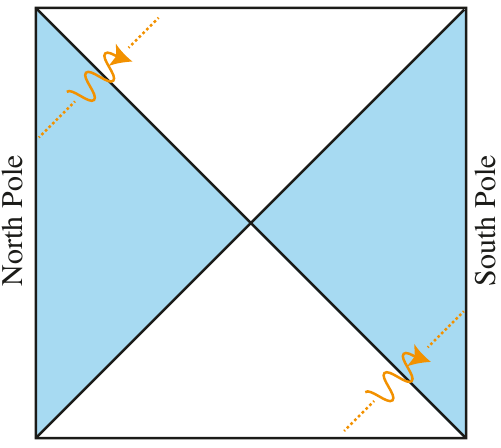
Figure 5 . In the thermofield double state, for each mode there is a maximally entangled mirror mode across the